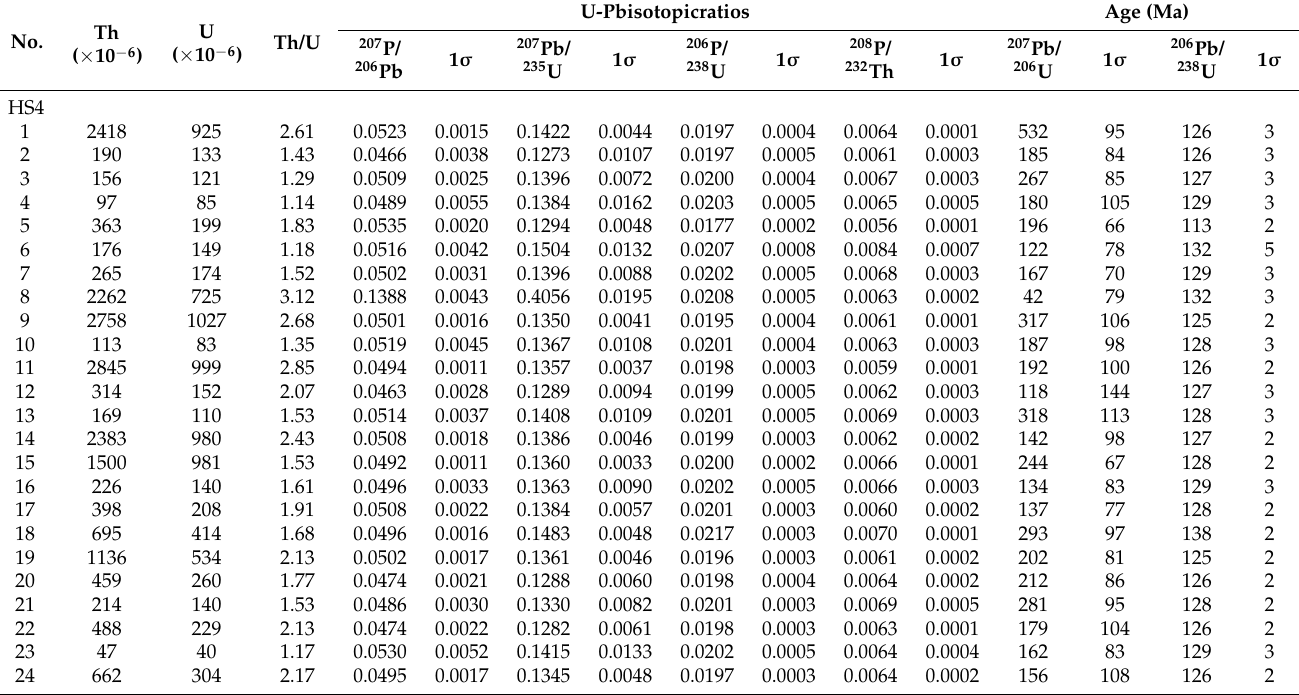
Table 1. LA-ICP-MS zircon U-Pb data of quartz monzonites from the Jinling complex pluton in western Shandong